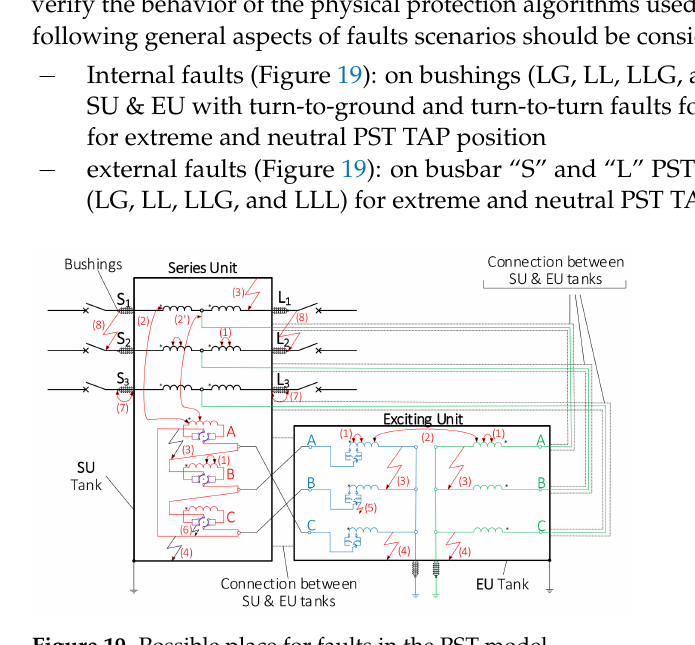
Figure 19. Possible place for faults in the PST